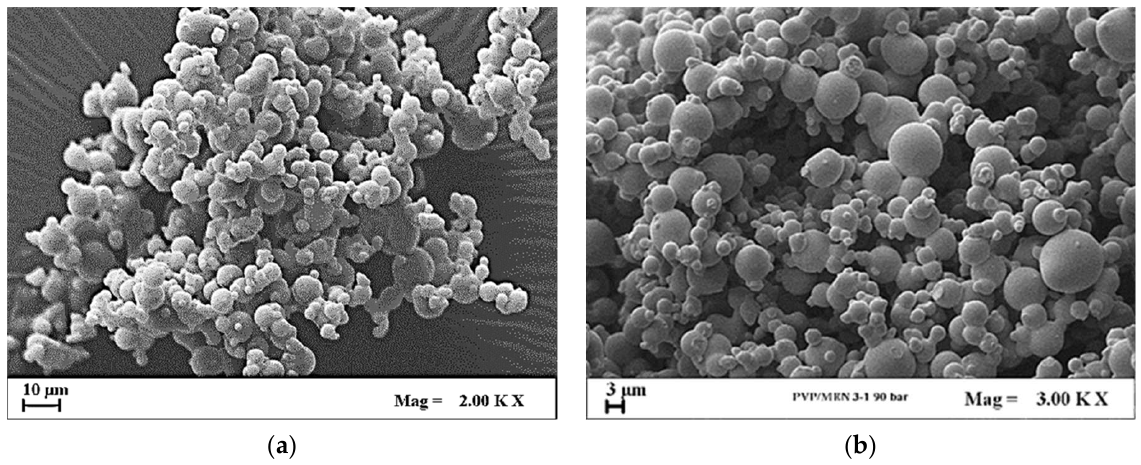
Figure 6. FESEM images of coprecipitated PVP/MEN particles at a 5/1 ( a ) and 3/1 ( b ) ratio, at 90 bar and 313 K.